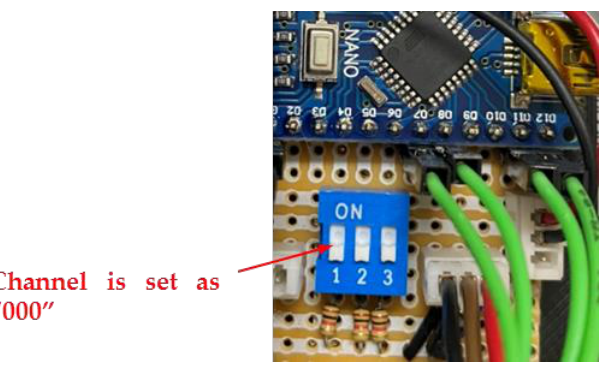
Figure 9. Channel setting example. The channel of the master extender is set to 000. Table 2. Adopted electronic components and their specifications in this work.